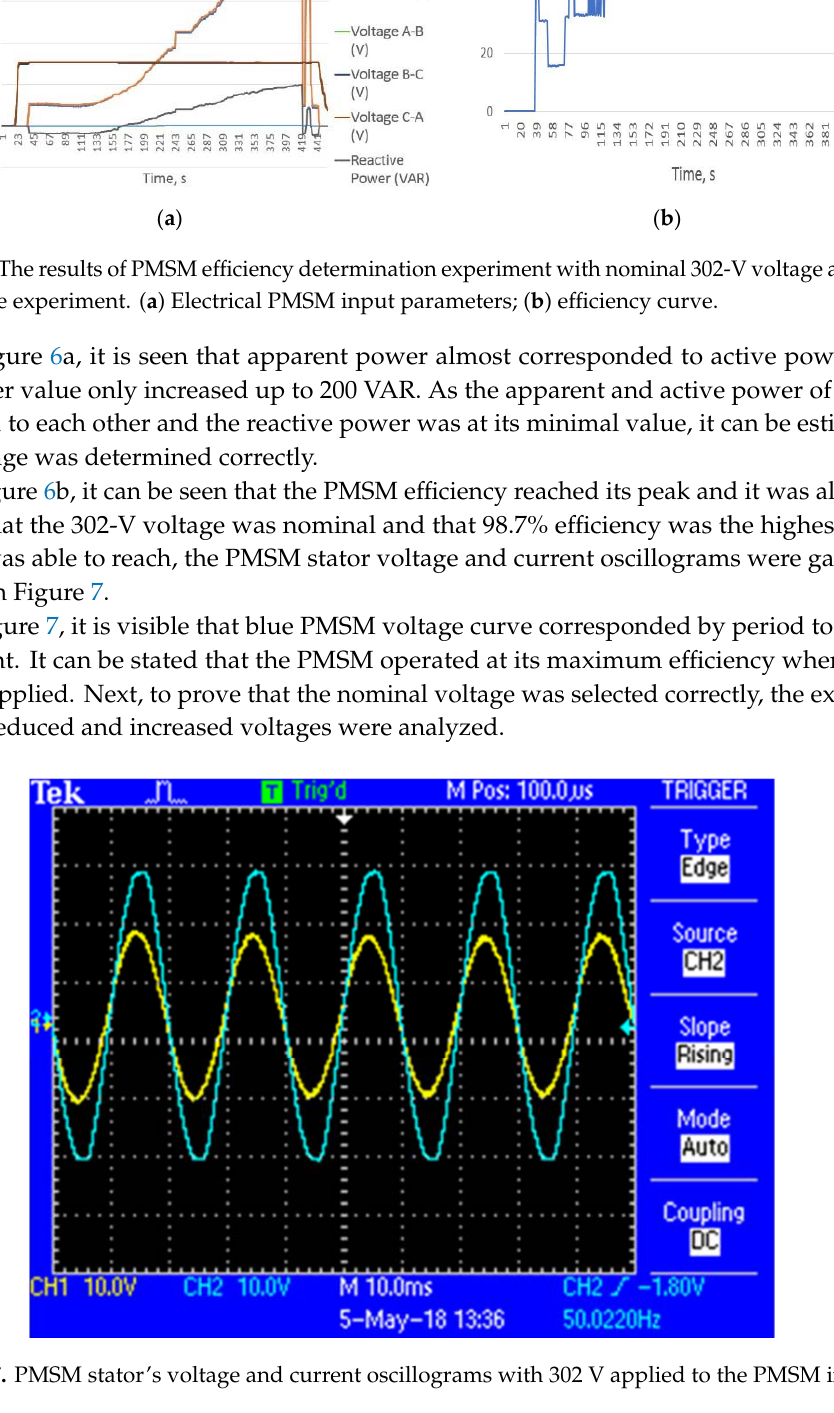
( b ) Figure 8. The results of the PMSM efficiency determination experiment with a reduced voltage of 240 V applied during the experiment. ( a ) Electrical PMSM input parameters; ( b ) efficiency curve. From Figure 8a, it is visible that reactive power increased up to 600–800 VAR. As a result, the apparent power did not coincide with active power, but during the reach of peak load where the efficiency curve in Figure 8b reached the highest values, the apparent power almost coincided with active power.